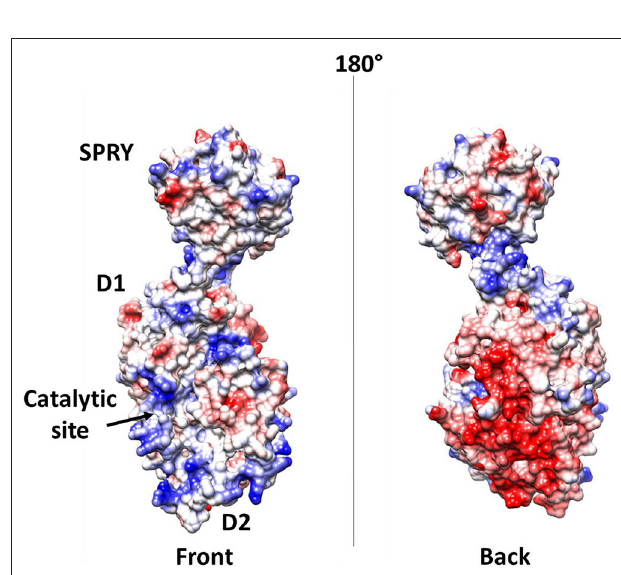
FIGURE 9 | Electrostatic potential surface of DDX1. Left and right panels show two opposite sides of the molecule.